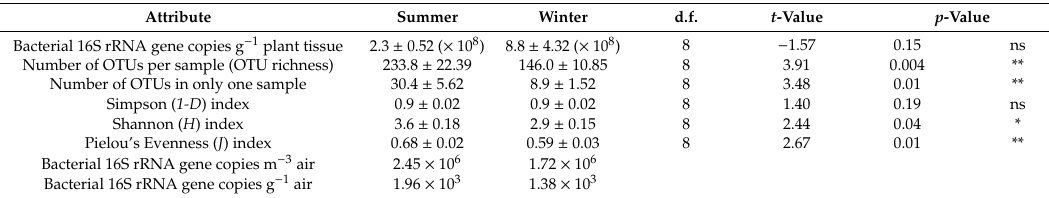
Table 2. Summary results regarding the OTUs detected in the phyllosphere of the Mediterranean ecosystem studied and in the surrounding air. Type of Bacterial OTUs Number OTUS in the phyllosphere